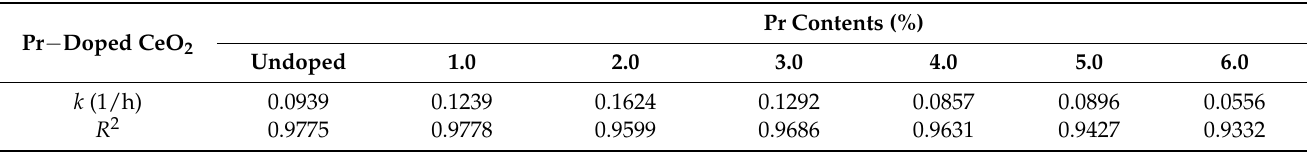
Table 2. Kinetic parameters for the degradation of AO7 dye onto Undoped CeO 2 and Pr-doped CeO 2 under ultraviolet lamp.